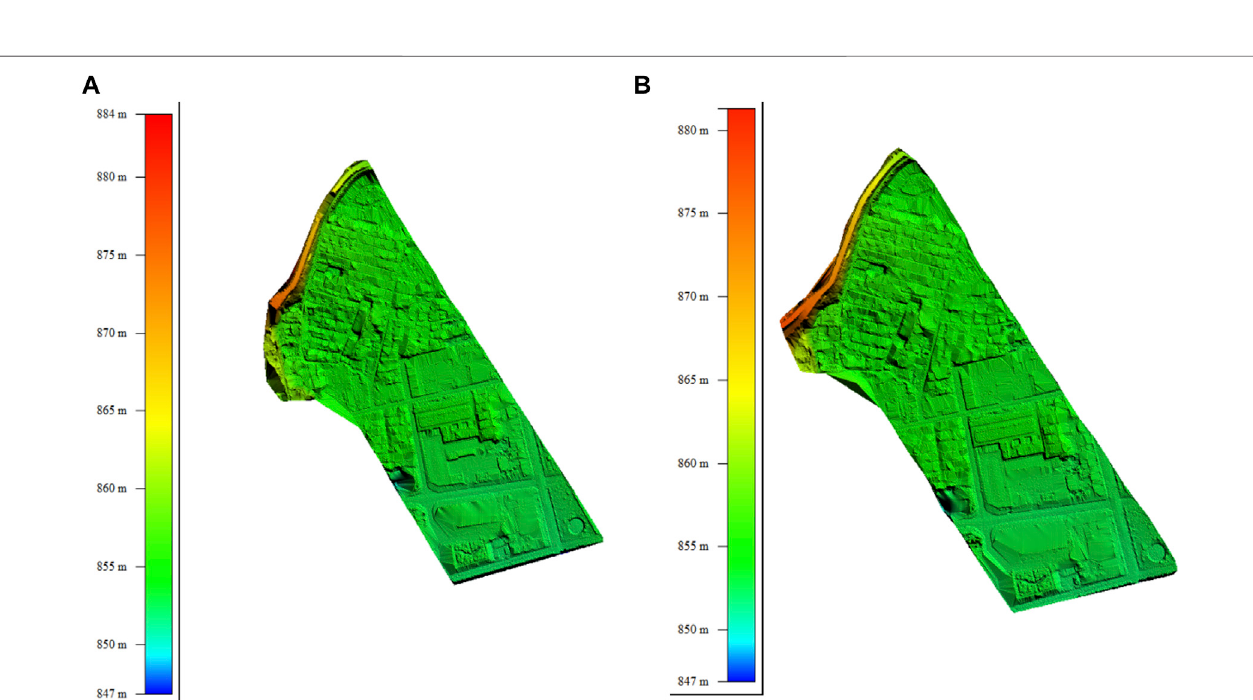
FIGURE 9 | DEM data results. (A) DEM of Phase I; (B) DEM of Phase